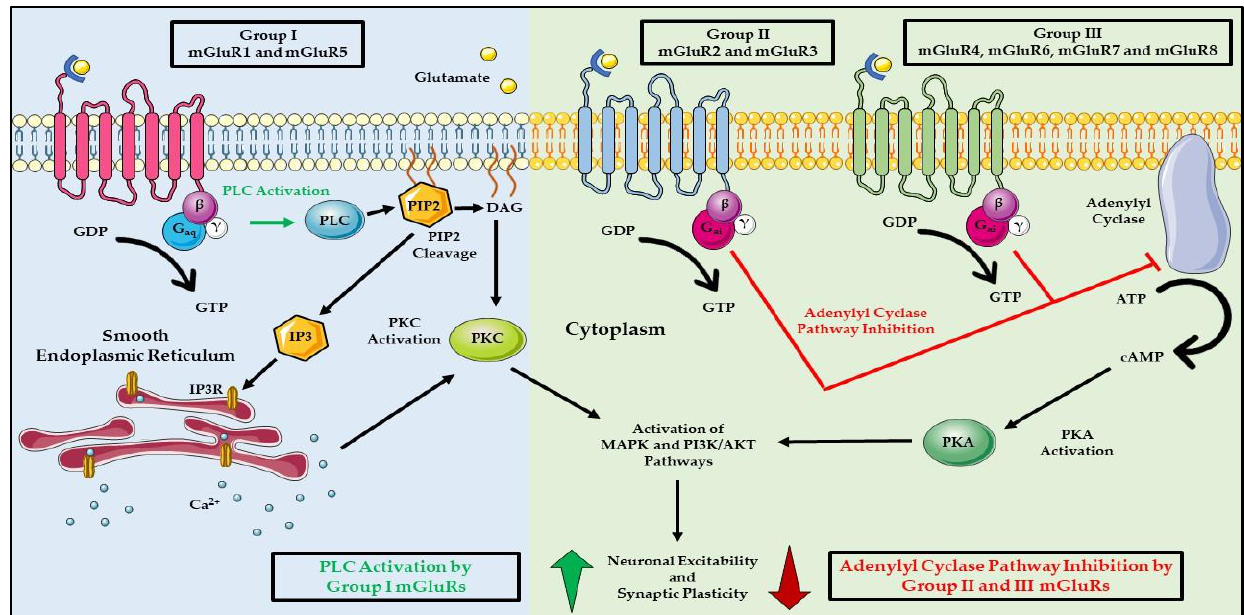
Figure 2. Modes of action of mGluRs. The known functions of Group I, II, and III mGluRs upon activation by the natural ligand, glutamate, with the downstream PLC and adenylyl cyclase signaling pathways. The straight black arrows indicate the cellular signaling pathway. The green arrows indicate activation process, and the red arrows indicate inhibition process. The curved black arrows indicate conversion of one molecule to another. Abbreviations: metabotropic glutamate receptors (mGluR: protein; Grm : mouse gene; GRM : human gene), guanine diphosphate (GDP), guanine triphosphate (GTP), phospholipase C (PLC), phosphatidylinositol-4,5-diphosphate (PIP 2 ), diacyl-glycerol (DAG), inositol 1,4,5-triphosphate (IP 3 ), inositol 1,4,5-triphosphate receptor (IP3R), protein kinase C (PKC), adenosine triphosphate (ATP), cyclic adenosine monophosphate (cAMP), and protein kinase A (PKA). Parts of the figure were created using pictures from Servier Medical Art.